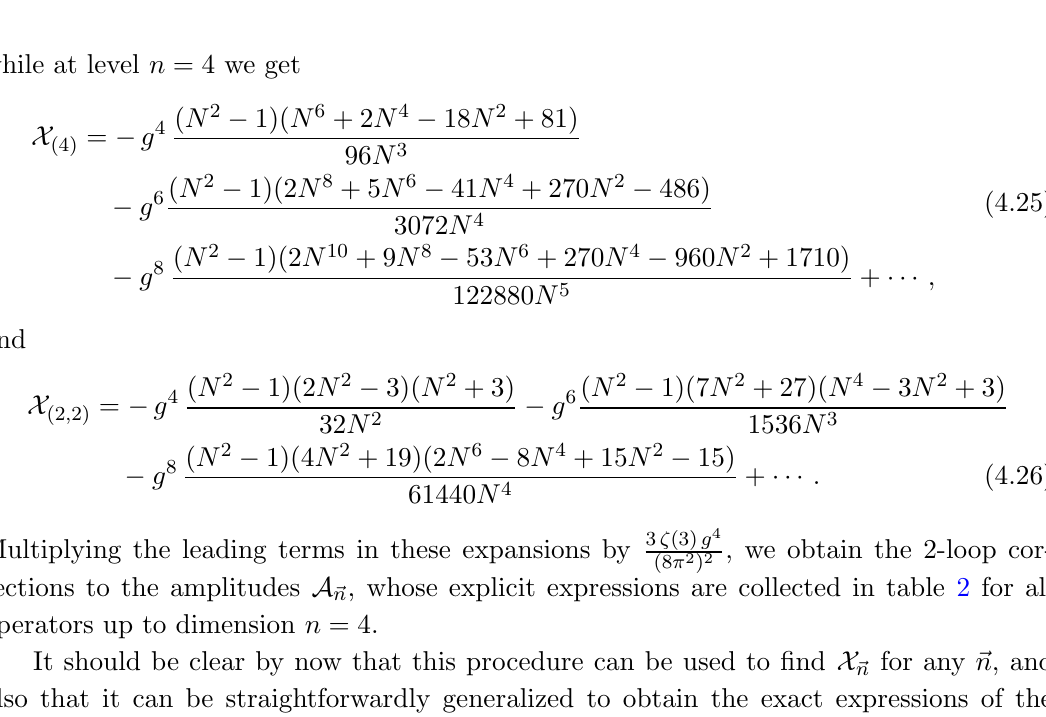
Table 2 . The 2-loop contribution to the di(cid:11)erence (cid:14) A ~n between the N = 2 and the N = 4 amplitudes for operators up to order n =